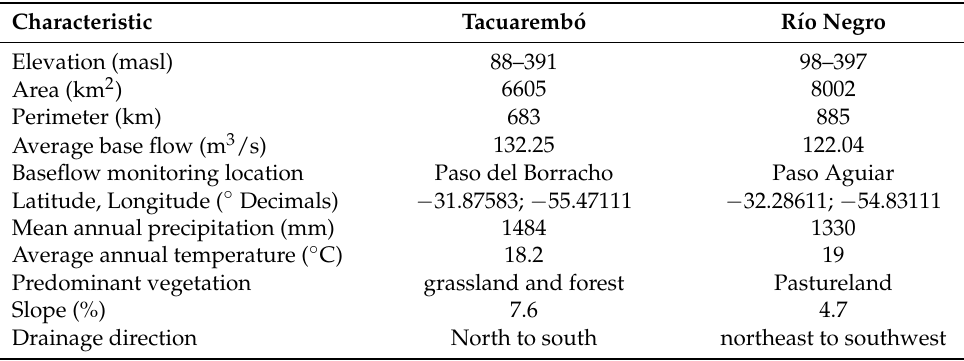
Table 1. Summary of the main characteristics of the basins under